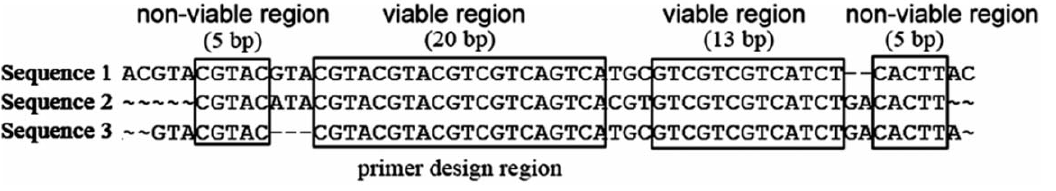
Figure 1. Identification of suitable primer design regions from a ClustalW generated sequence alignment (The parameter setting for the minimum primer length was 18).